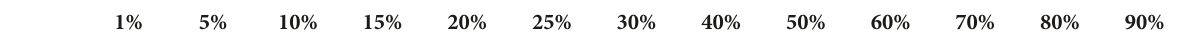
TABLE 3 The group average sensitivity and specificity values (with standard error of the mean) are listed in this table at each threshold